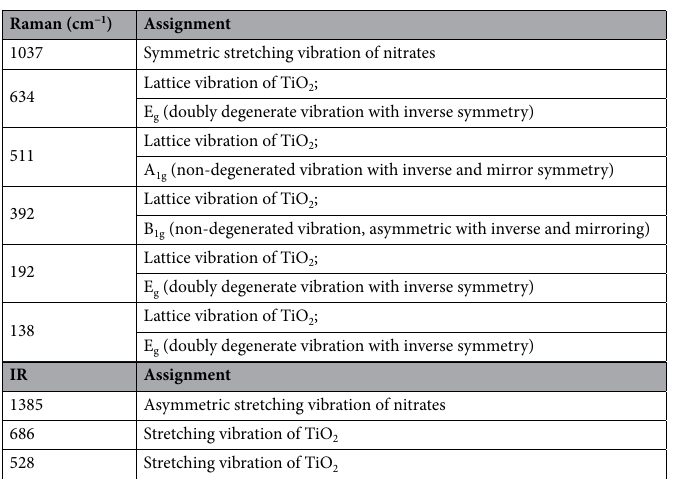
Table 2. The band assignment of spectra of TiO 2 -A-n% Ag sample series.